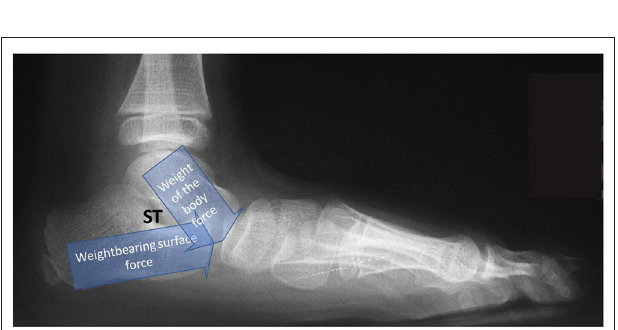
FIGURE 3 | Weightbearing lateral foot radiograph of a foot in resting stance position showing partial dislocation of the talotarsal joint illustrating joint forces. Loss of TTJ alignment occurs at the initial stage of full plantar foot contact. Sinus tarsi is obliterated. Excessive forces are thrust on the